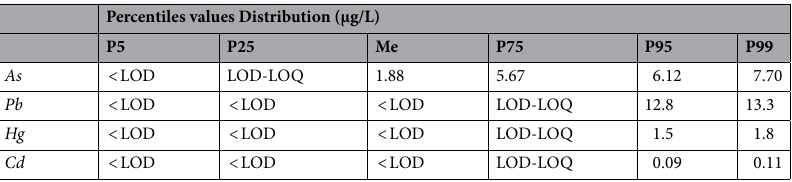
Table 3. Prevalence of detection and quantification of heavy metals in Popokabaka Children, n (%) = 412 Children LOD = Limit of detection, LOQ = Limit of Quantification